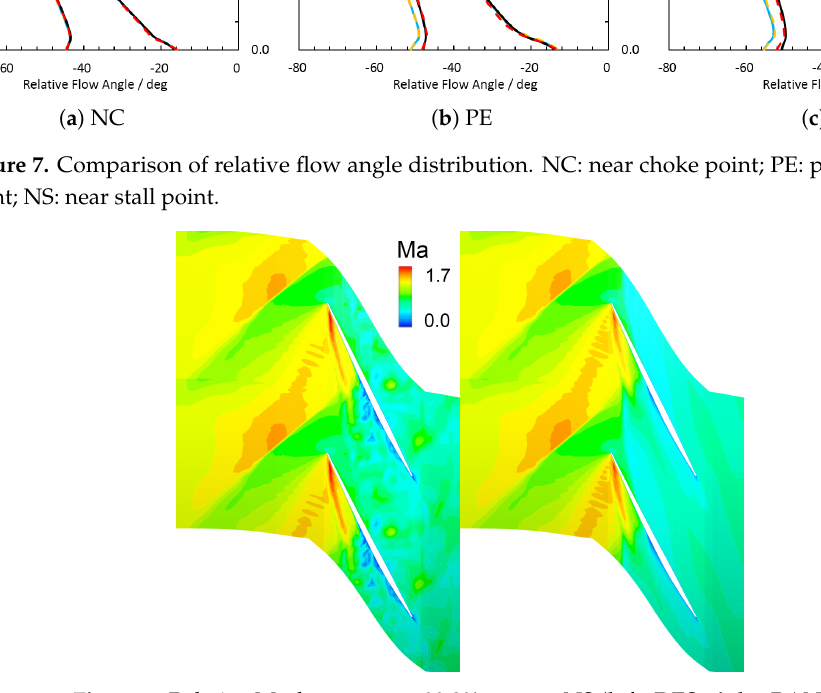
Figure 8. Relative Mach contour at 99.3% span at NS ( left : DES, right :